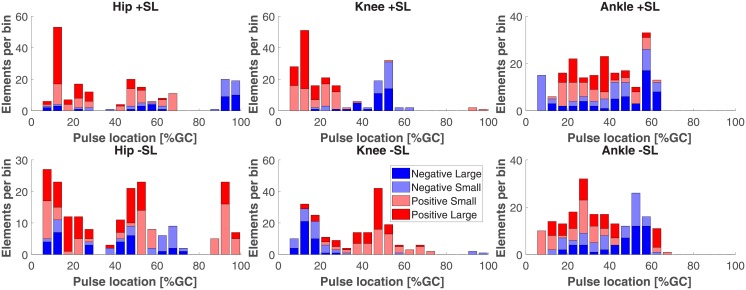
Histogram of two pulse approximation locations in gait cycle, sorted by pulse amplitude sign and magnitude.